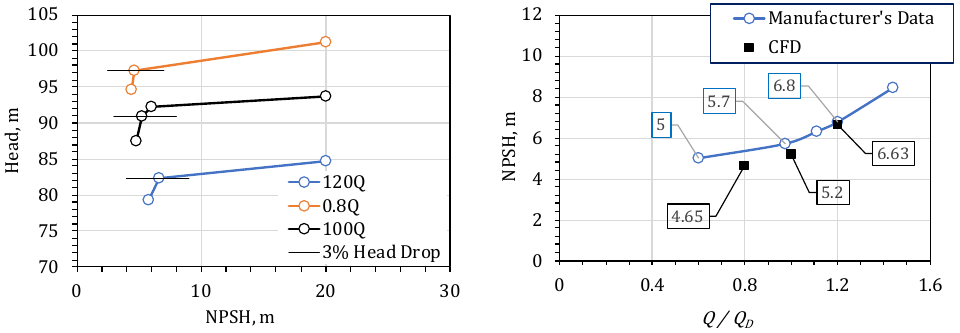
Figure 14. NPSH values, as predicted using a novel approach [14]. ( Left ) head-drop curve. ( Right ) NPSH characteristic curve.